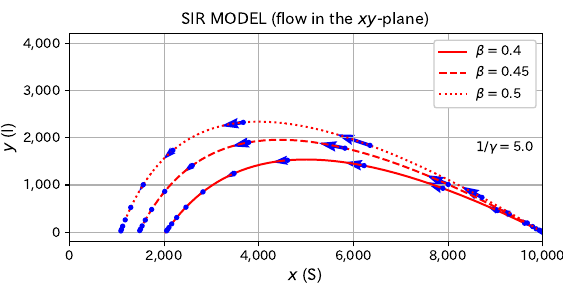
Figure 6. Directions of flow in the xy -plane for the SIR model. The parameters are the same as in Figure 5. Every 5 in t , the directions of flow are depicted by arrows. The length of the arrow is measured for the period of 1.2 in t